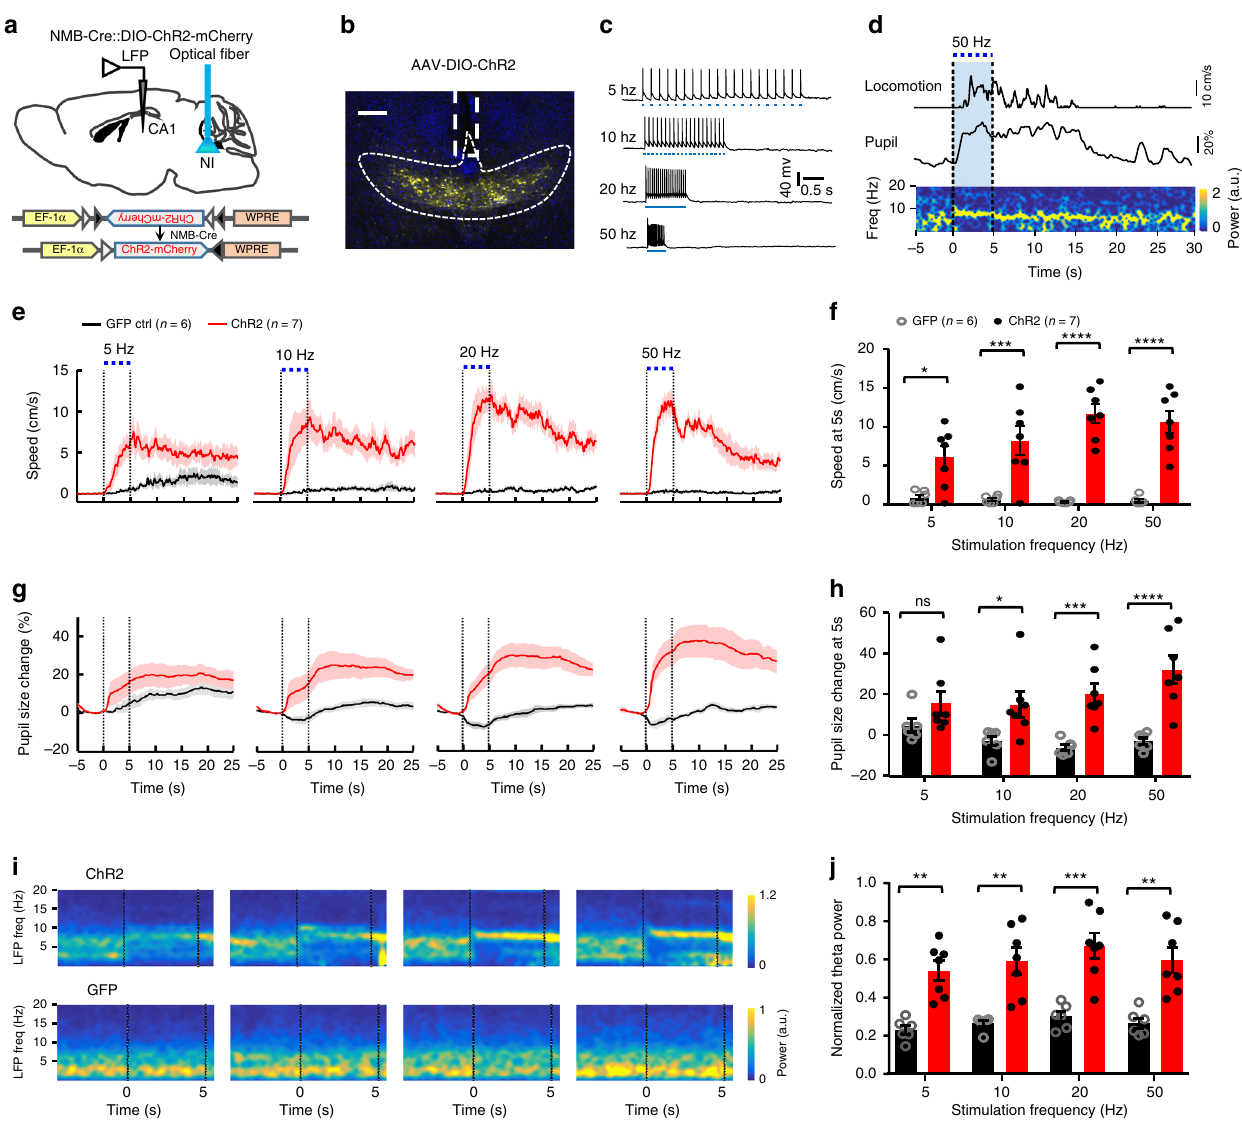
Fig. 3 Activating NI NMB neurons promotes locomotion, arousal, and theta power. a Experimental schematic for viral expression of ChR2, stimulating NI NMB neurons, and recording hippocampal LFP. b A coronal section shows ChR2-mCherry expression in NI NMB neurons. Scale bar = 200 µ m. c Recording from brain slices con fi rmed that brief blue laser pulses at 5, 10, 20 and 50 Hz (5 ms width, 5 mW) reliably elicited the fi ring of action potentials in a ChR2- expressing NI neuron. d A representative example showing the effect of optogenetic activation of NI NMB neurons (blue bar) on inducing locomotion, arousal, and theta oscillations. e Locomotor speed aligned to different frequency laser onset. f Summary of the stimulation effects on locomotor speed. g , h The effect of optogenetic activation of NI NMB neurons on the pupil diameter across time ( g ) and summary data ( h ). i , j Grand average of LFP spectrograms for the entire test group ( i ) and summary data on the theta power ( j ). Shaded areas ( e , g ) and error bars ( f , h , j ) indicate SEM. * P < 0.05, ** P < 0.01, *** P < 0.001, **** P < 0.0001; ns, not signi fi cant; Tukey ’ s multiple comparisons test; see Supplementary Table 1 for detailed statistical analysis. Source data are provided as a Source Data fi